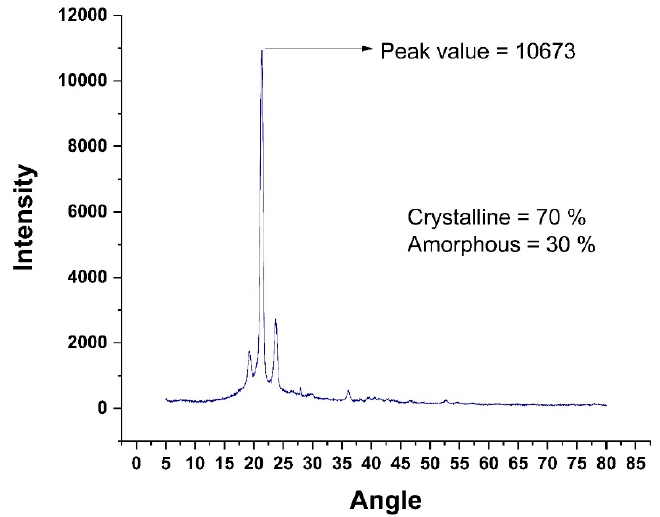
Figure 2. XRD Analysis of Irradiated HDPE at 100 kGY . Table 2. Chemical composition of constituents of plastic concrete .